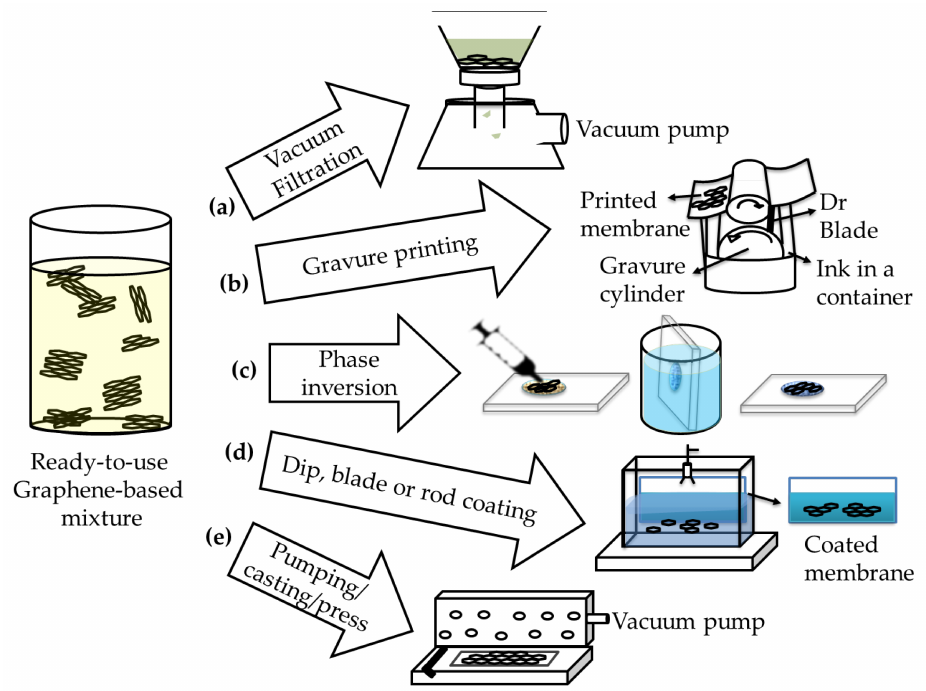
Figure 6. An illustration to the nanocomposite membrane preparation methods; ( a ) vacuum fil- tration, ( b ) gravure printing, ( c ) phase inversion, ( d ) dip-, blade- or rod-coating, and ( e ) pump- ing/casting/press with or without